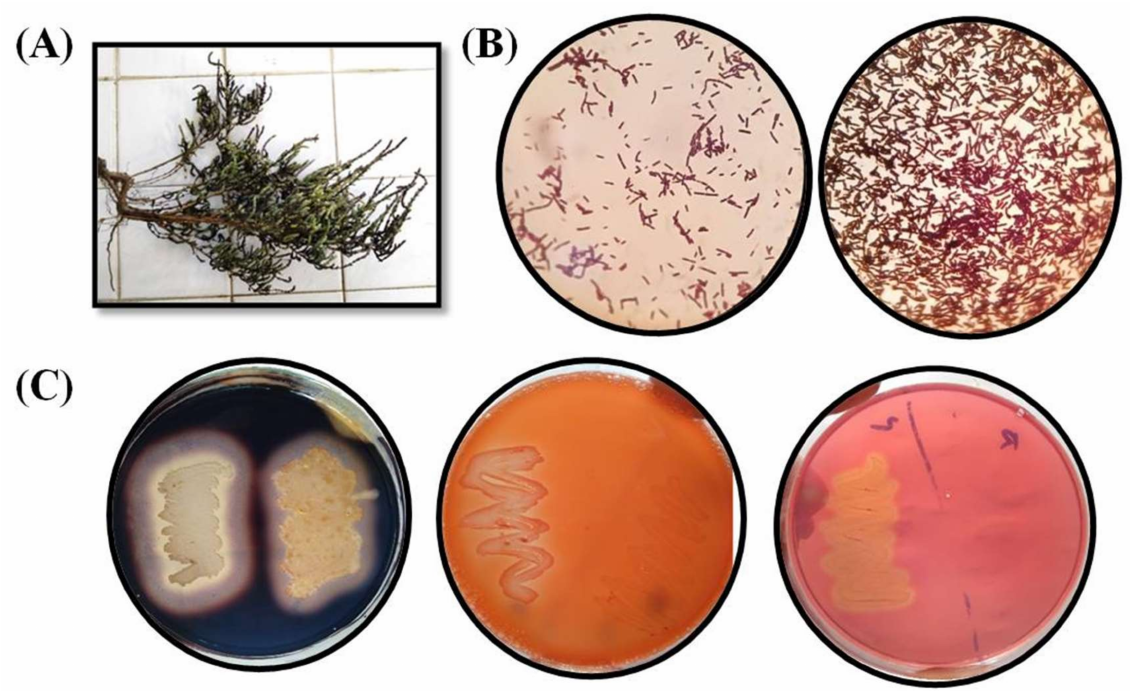
Figure 1. ( A ) Plant sample of A. macrostachyum collected from Kaka Pir, Sandspit, Karachi, Pakistan. ( B ) Microscopic examination of the isolates showing Gram-positive rods with scattered and chain arrangements. ( C ) Qualitative enzyme production showing clear zones around the streak patterns indicating production of specific